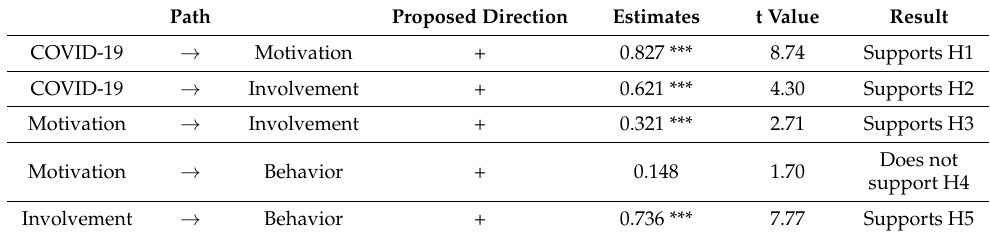
Table 4. Main latent variables’ structure path.